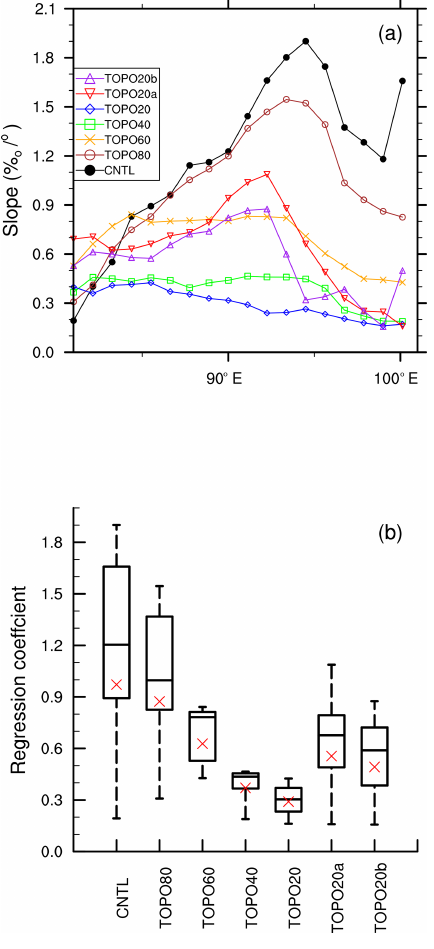
Figure 12. (a) The slope (in ‰ ◦− 1 ) of the linear regression of annual-mean precipitation-weighted δ 18 O p on latitude from ECHAM5 output, used as an approximation for the meridional gra- dient of δ 18 O p . (b) The box plot shows the variability of the merid- ional gradient of δ 18 O p . The red “x” indicates mean values for each scenario, calculated by regressing longitudinally averaged δ 18 O p across the Tibetan Plateau on latitude. Box plots show minimum, maximum, median, and quartile values.